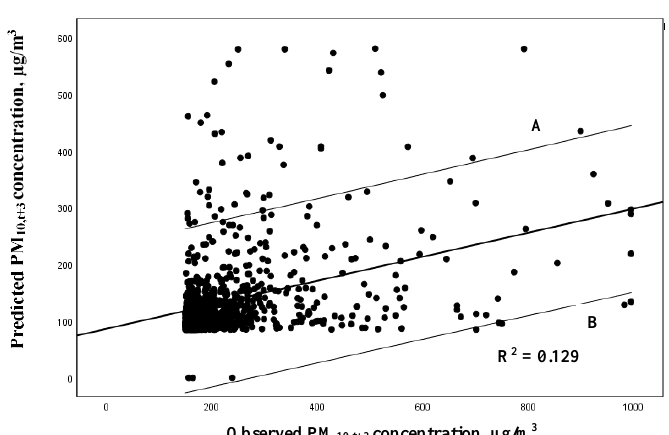
Table 5. Summary of performance indicator for all PM 10 forecasting models during the transboundary haze events.